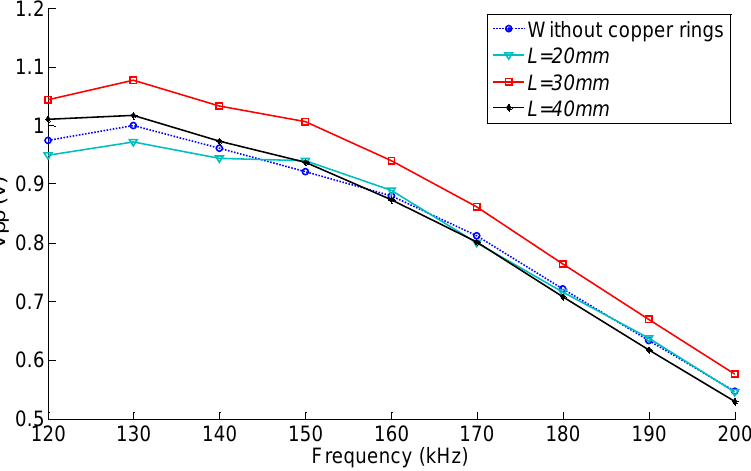
Figure 19. The peak to peak amplitudes ( V conditions (without copper rings, L = 20 mm, L = 30 mm, L = 40 mm).